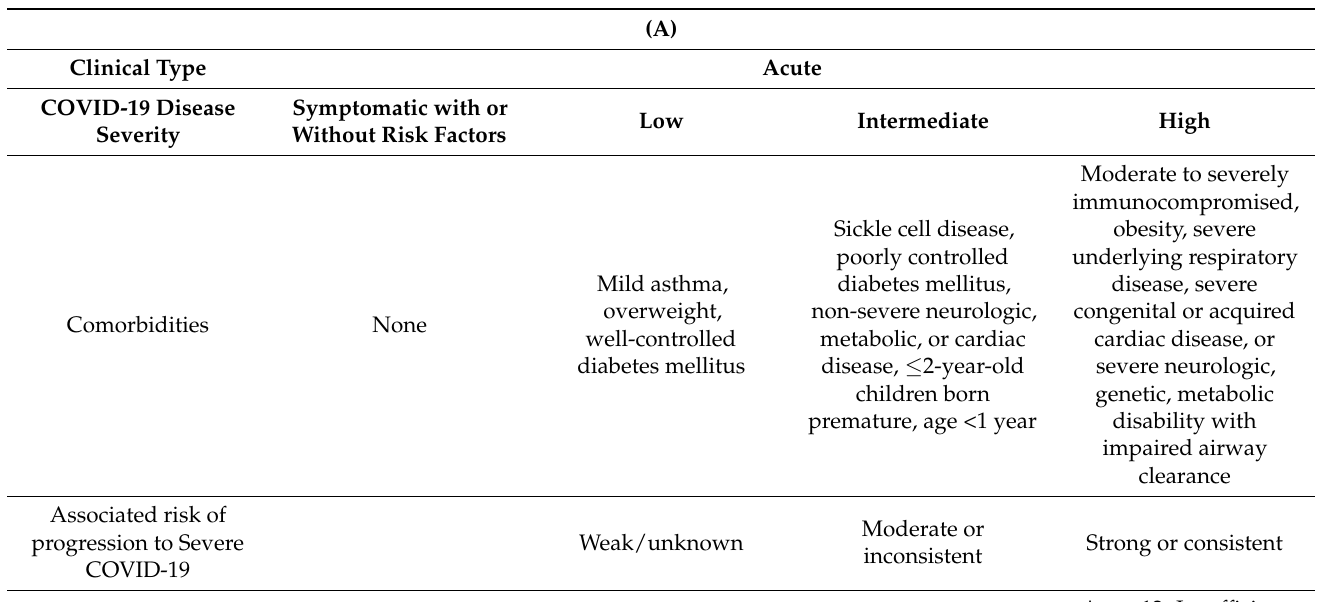
Table 1. ( A ) Recommended COVID-19 management in non-hospitalized children [53,54]; ( B ) recom- mended COVID-19 management in hospitalized children [53,55]; ( C ) recommended MIS-C manage- ment in hospitalized children